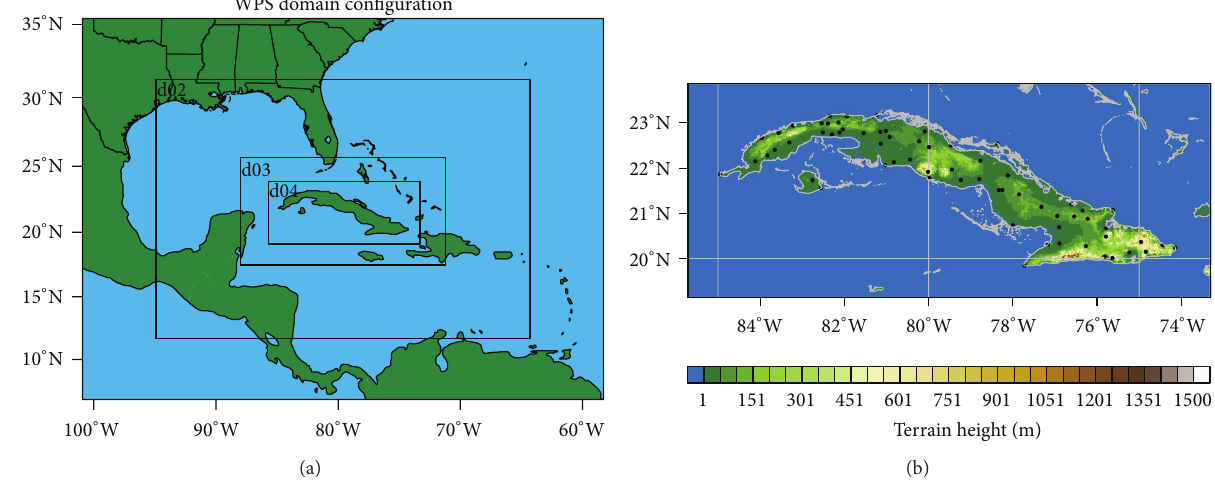
Figure 2: (a) Domain design and (b) meteorological stations shown in domain